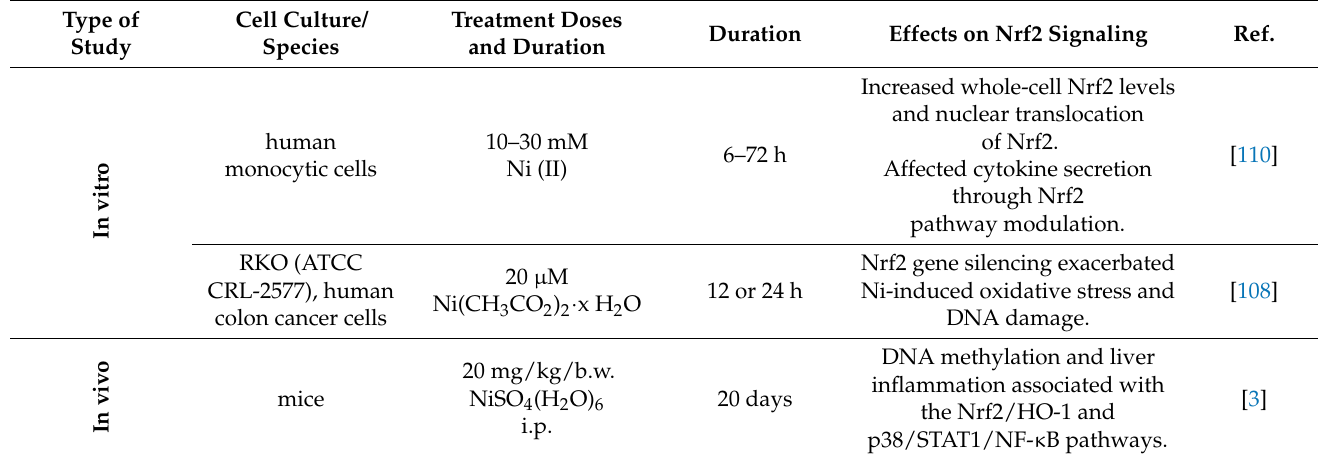
Table 5. Summary of studies analyzing the effects of Ni on Nrf2